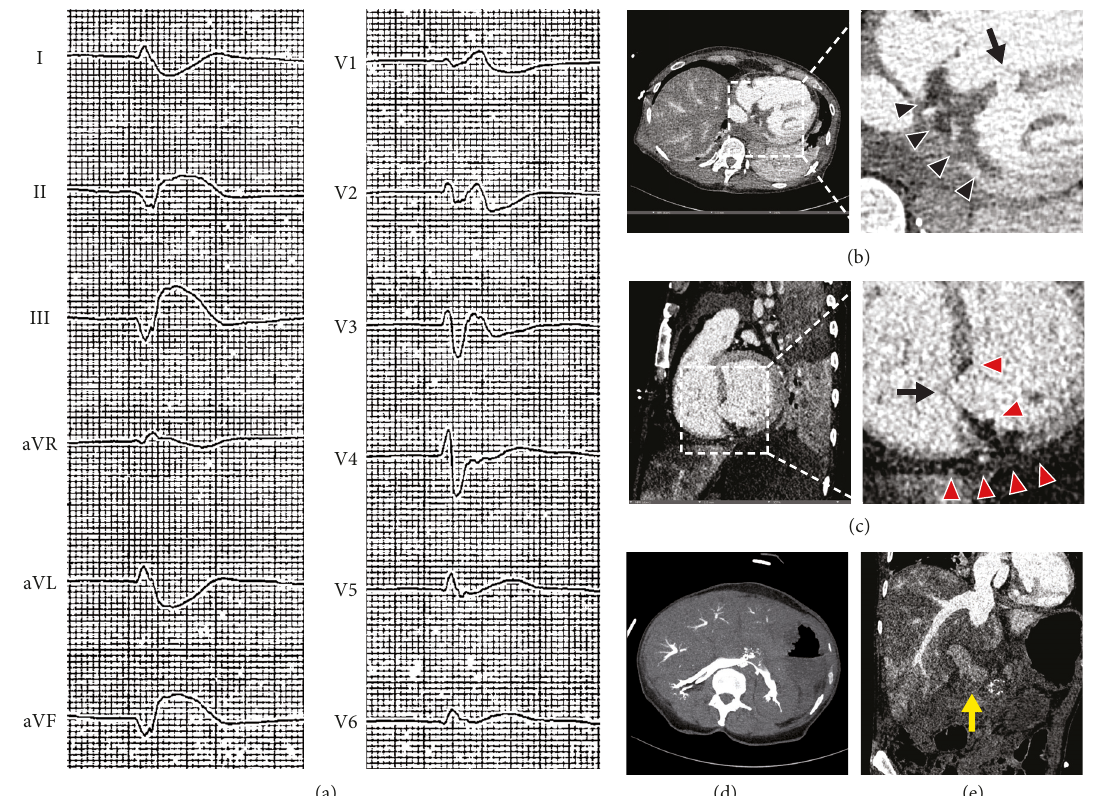
Figure 1: Signs and consequences of ventricular septal rupture due to acute myocardial infarction. (a) ECG. ST-segment elevation in leads II, III, aVF, and V6. (b) to (e): Computed tomography. (b) Transverse plane. Acute inferior myocardial infarction (black arrowheads) and ventricular septal rupture (black arrow), both associated with dilation of the right ventricle and retrograde flow of contrast agent into the liver veins due to acute right heart failure. (c) Sagittal plane. Ventricular septal rupture (black arrow) due to acute myocardial infarction with extensive microvascular obstruction (red arrowheads). (d) Transverse plane, arterial phase after intravenous injection of contrast agent. Contrastis seen in renal and hepaticveins as a sign of severevenous congestion. (e) Sagittal oblique plane, latephase after injection of contrast agent. Hepatic veins, hepatic parenchyma, and the portal vein (yellow arrow) are still opacified due to backward failure of the right